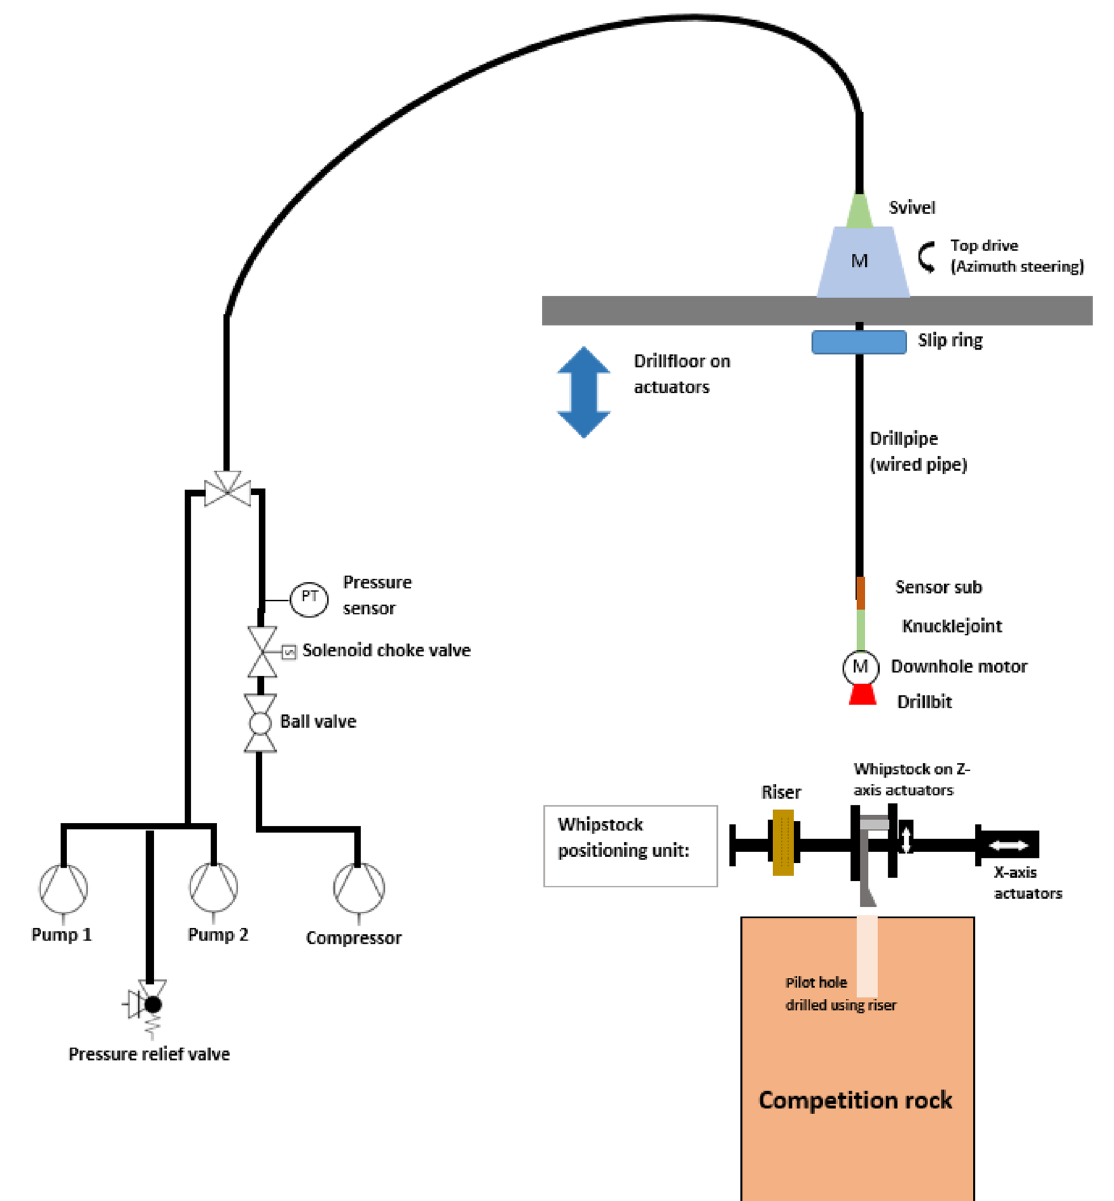
Fig. 2 Schematics of the rig construction